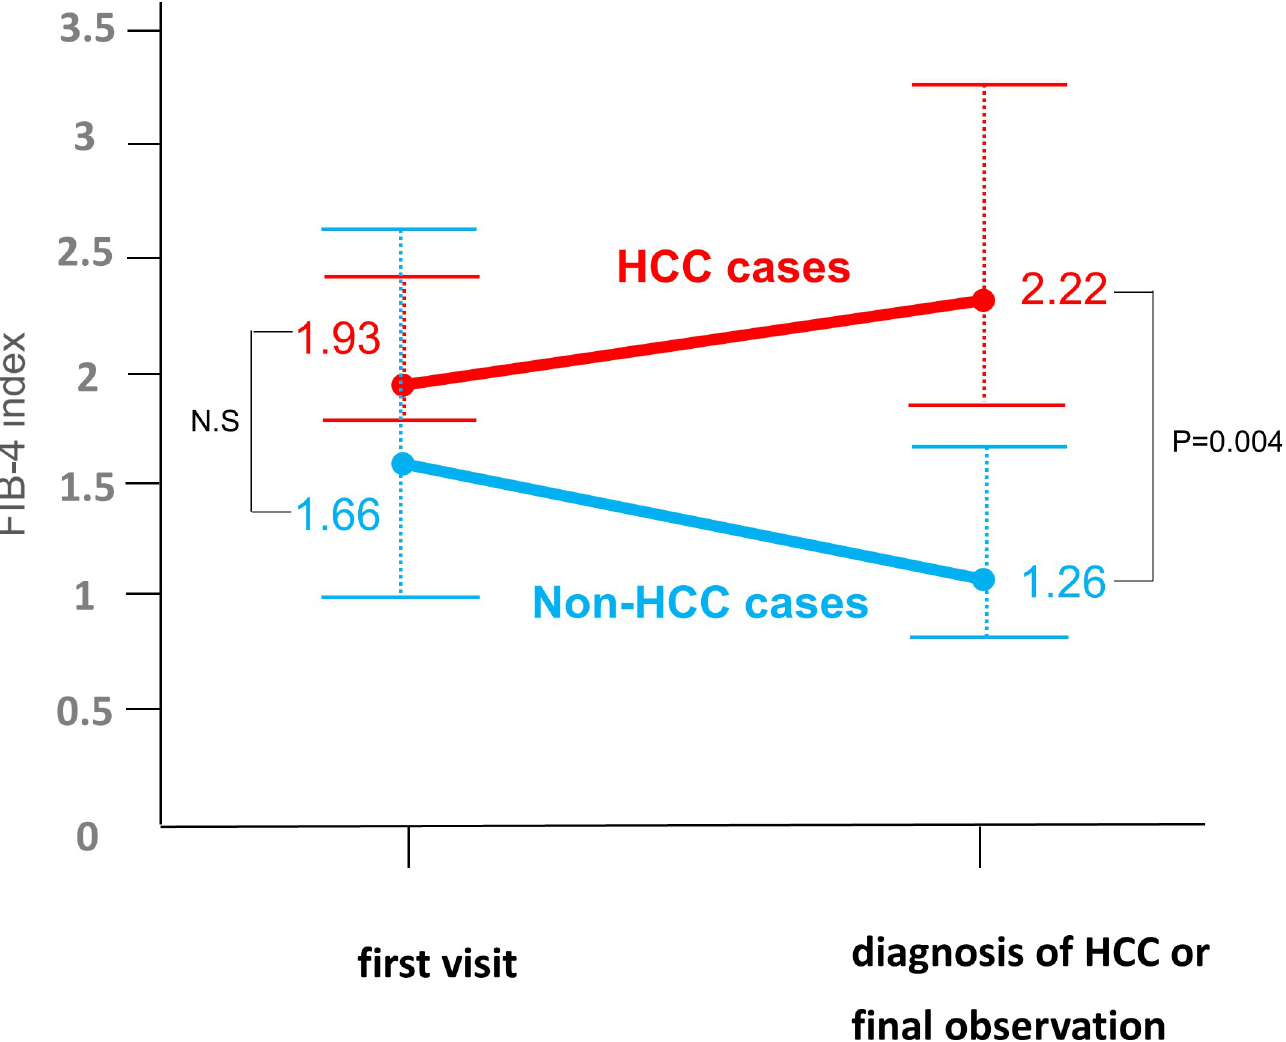
Fig 3. Transition of FIB4-index in CH group. We depict the transition of FIB-4 index levels from the first visit to our hospital to the diagnosis of hepatocellular carcinoma (HCC) or the last follow-up visits of patients who did not develop HCC. Red line and numbers represent mean FIB-4 index levels in the HCC cases, and those in blue represent in the non-HCC cases. FIB-4 index levels were compared between the HCC and the non-HCC groups at the first visit and the diagnosis of HCC or the last follow-up visits using the Mann-Whitney U test. Above the horizonal line represents third quantile, and below the horizonal line represents first quantile. Abbreviations: FIB-4, fibrosis-4; CH, chronic active hepatitis; HCC, hepatocellular carcinoma.